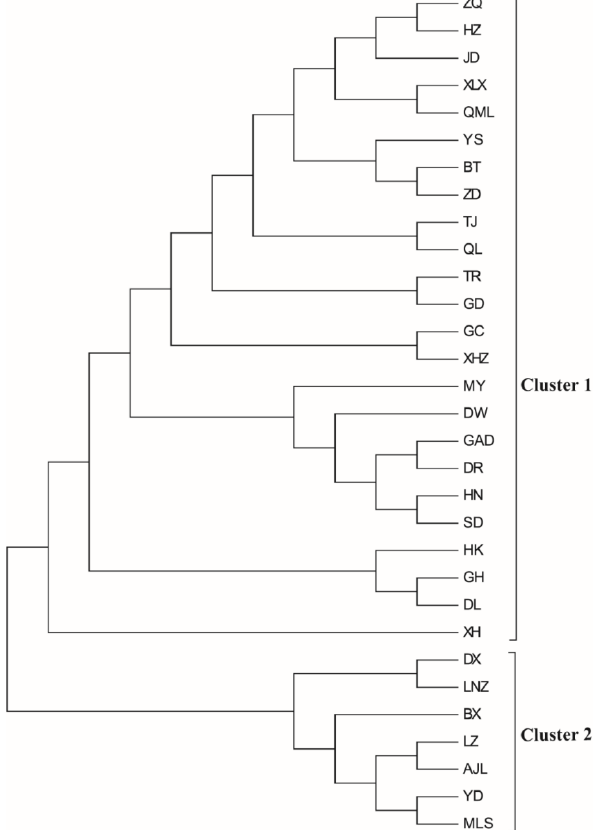
Figure 2. Neighbor-joining (NJ) tree of L. tibetica populations based on genetic distance.